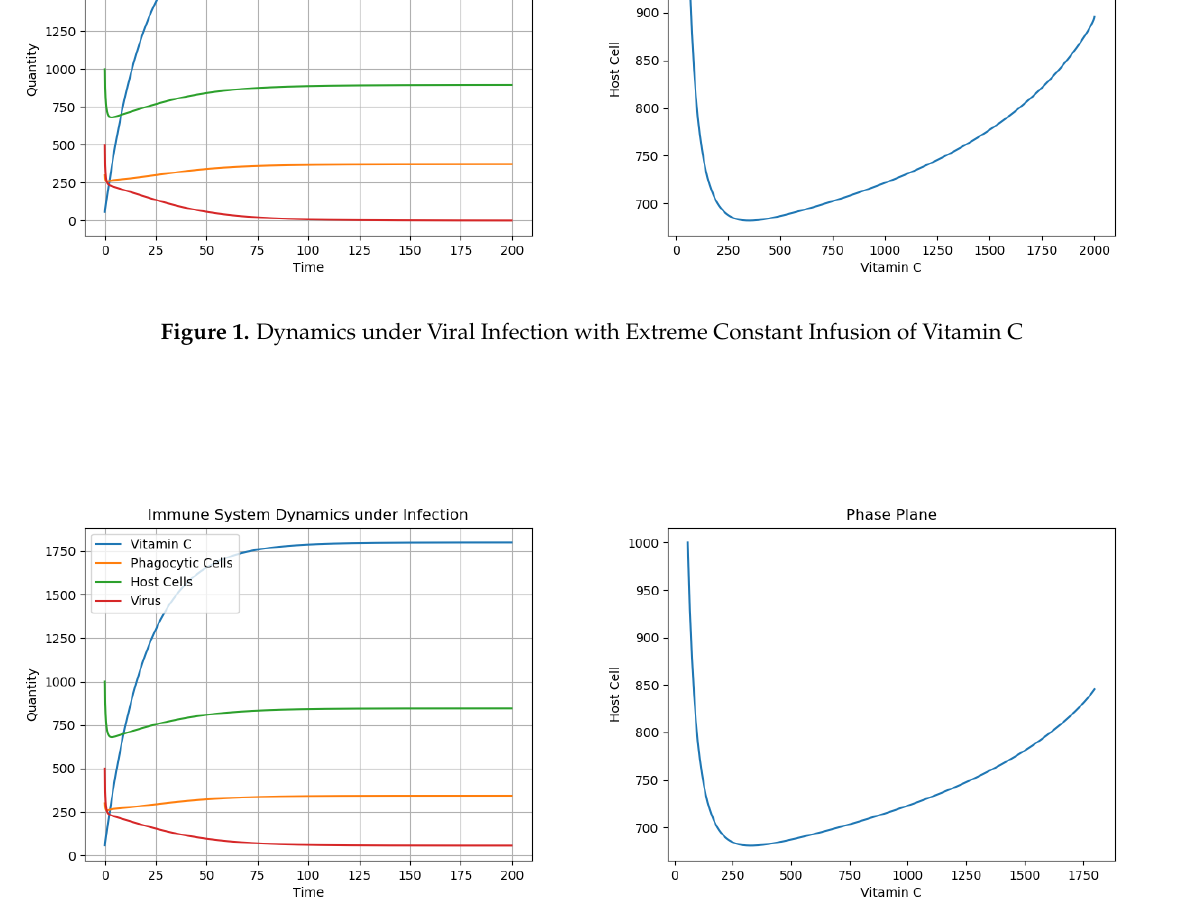
Figure 2. Dynamics under Viral Infection with Moderate Constant Infusion of Vitamin C